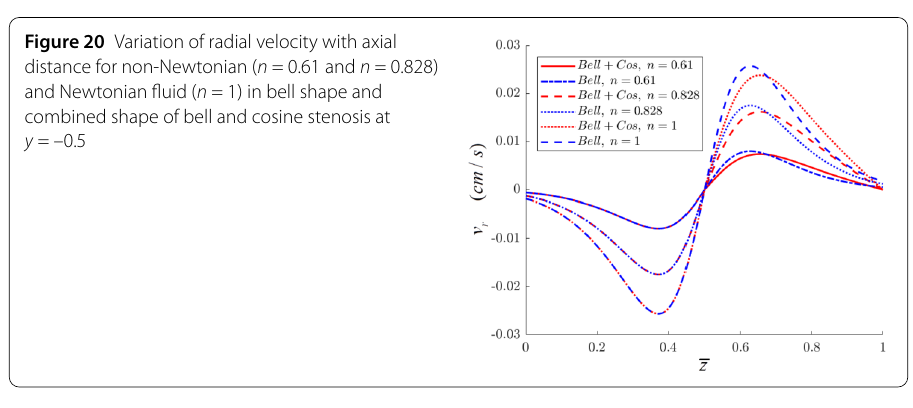
Figure 21 Variation of radial velocity with radial distance for non-Newtonian ( n = 0.61 and n = 0.828) and Newtonian fluid ( n = 1) in cosine shape and combined shape of cosine and bell stenosis at ¯ z =